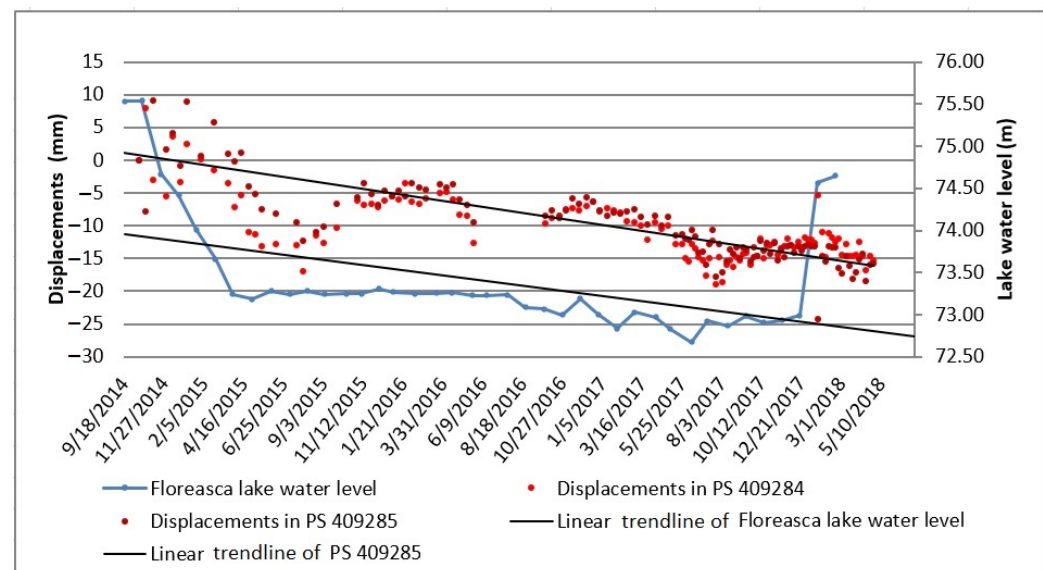
Figure 10. Comparison between the Floreasca Lake water level and the evolution of the land vertical displacements in the Gara Her ă str ă u area. Source: elaborated by the authors.